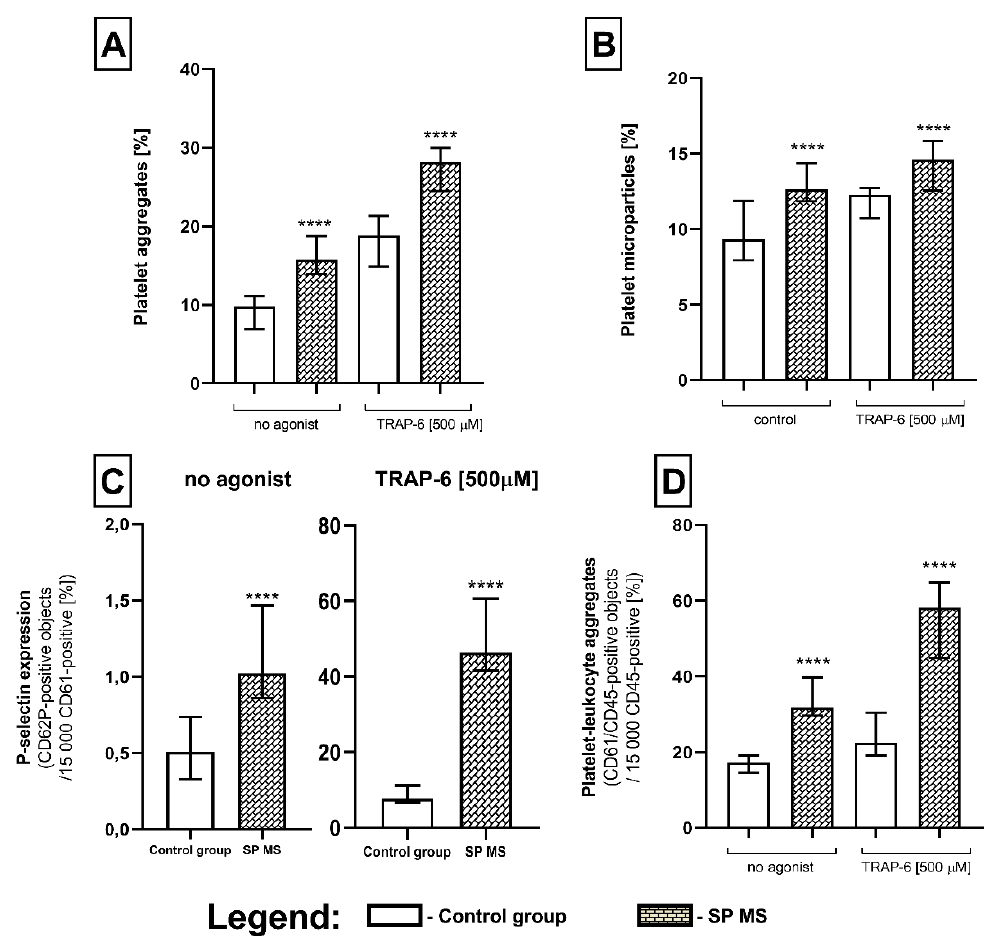
Figure 1. Platelet activation markers measured by double-labeled flow cytometry. The level of platelet aggregates (PAGs) ( A ) and platelet-derived microparticles (PMPs) ( B ) expressed as the percentage of platelet aggregates relative to the total platelet pool (15,000 CD61-positive objects). P-selectin expression level presented as the percentage of CD61 / CD62-positive targets in the total platelet pool (15,000 CD61-positive targets) ( C ), as well as level of platelet-leukocyte aggregates (PLAs) relative to the total leukocyte pool (15,000 CD45-positive objects) ( D ). Statistical analysis was performed using the Mann–Whitney U test. The results are expressed as a median and interquartile range (IQR), **** p < 0.0001.